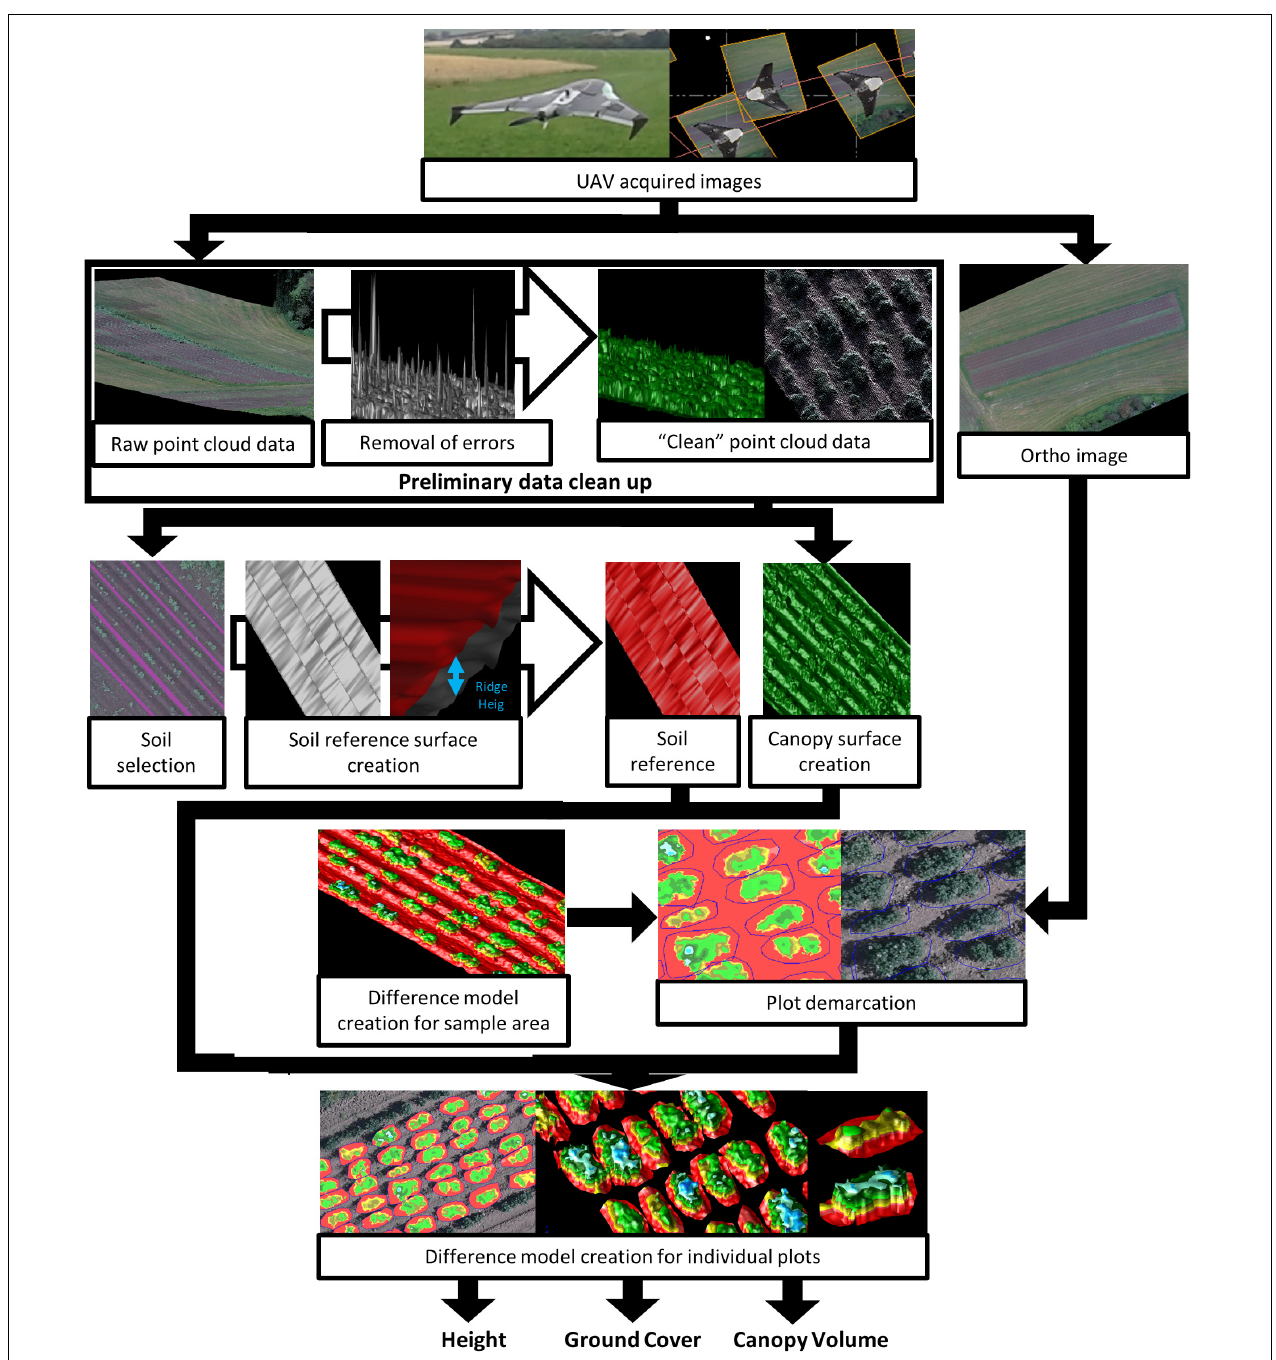
FIGURE 2 | Methodological flowchart showing the acquisition of quantitative data on potato plant canopy structure (e.g., canopy volume, canopy ground cover, and plant height) using a Structure from Motion algorithm from UAV acquired images.